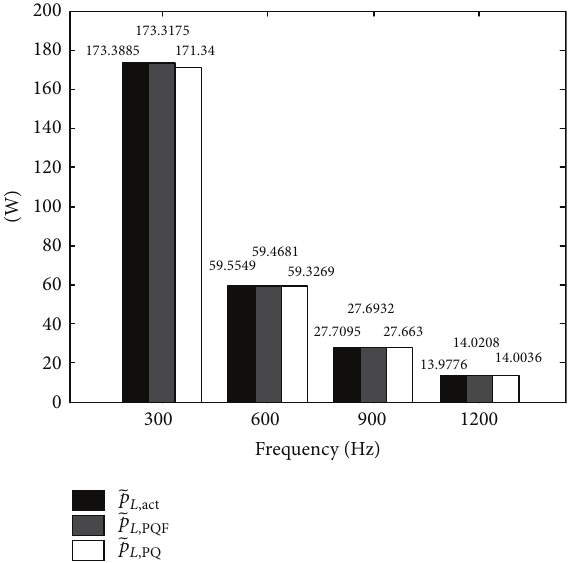
Figure 6: The spectrum of instantaneous active power for harmonic components.